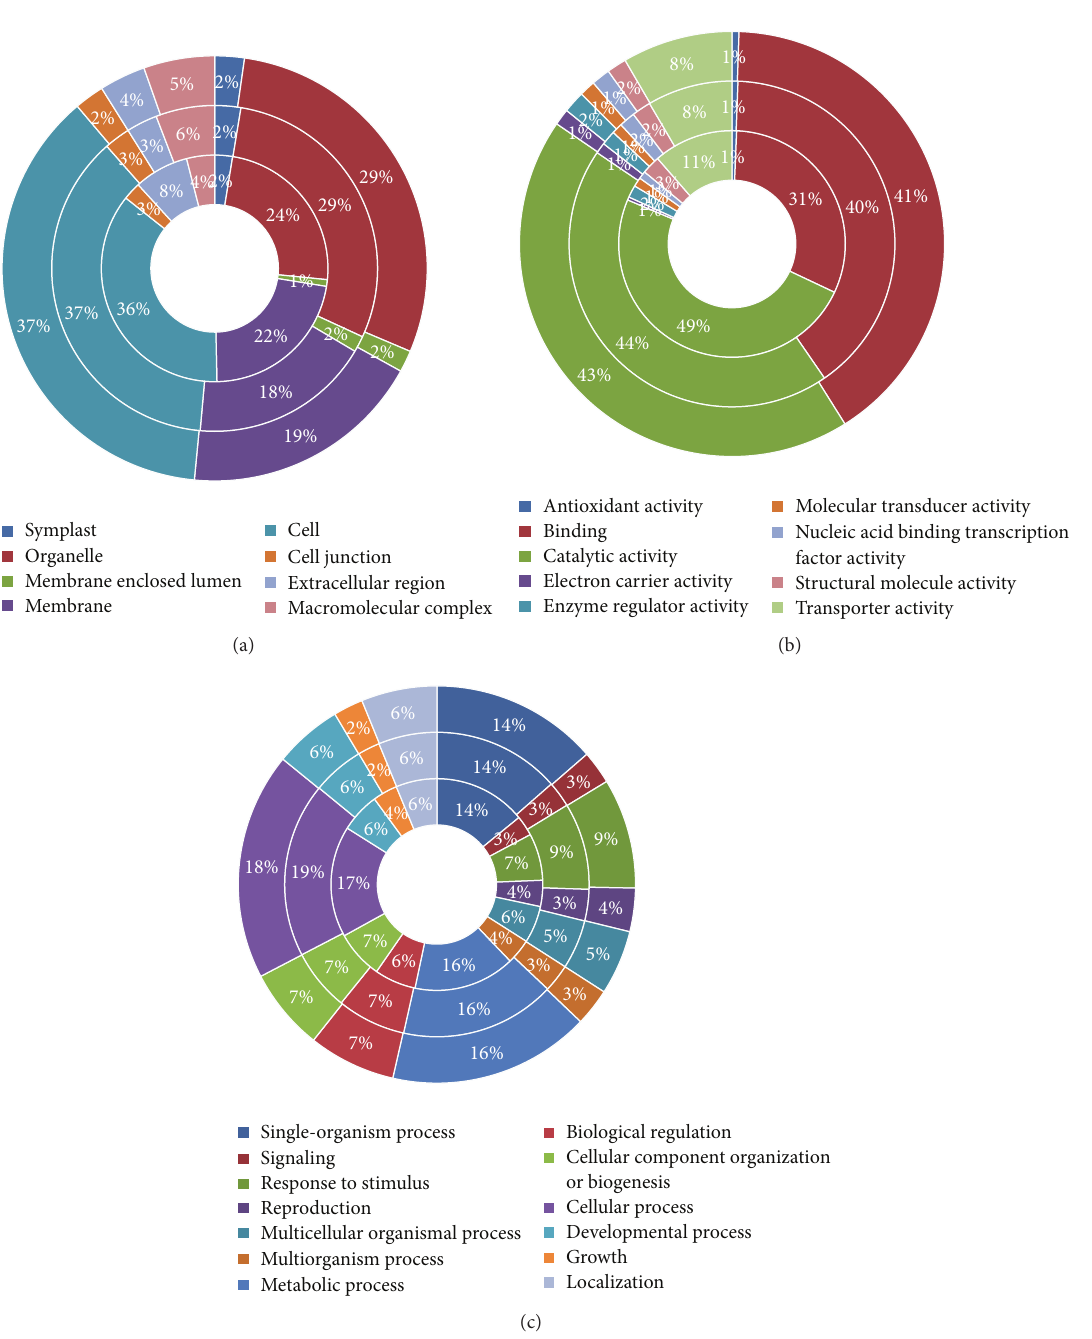
Figure 2: Distribution of ontological categories (level 2 GO terms) in self-sterile (inner chart), cross-pollinated (middle chart), and self-fertile cvs (outer chart) DE transcripts according to cellular component (a), molecular function (b), and biological process (c). The percentage of the transcripts within each class is